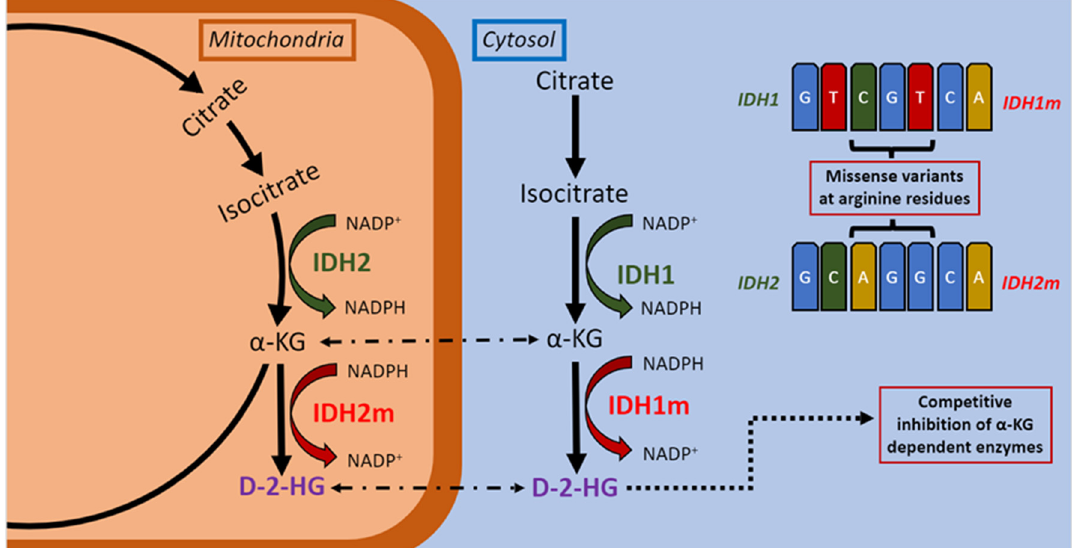
Figure 1. Function of wildtype IDH1/2 enzymes by intracellular compartment, with induction of oncometabolite D -2-HG by mutant IDH1/2 enzymes demonstrated.